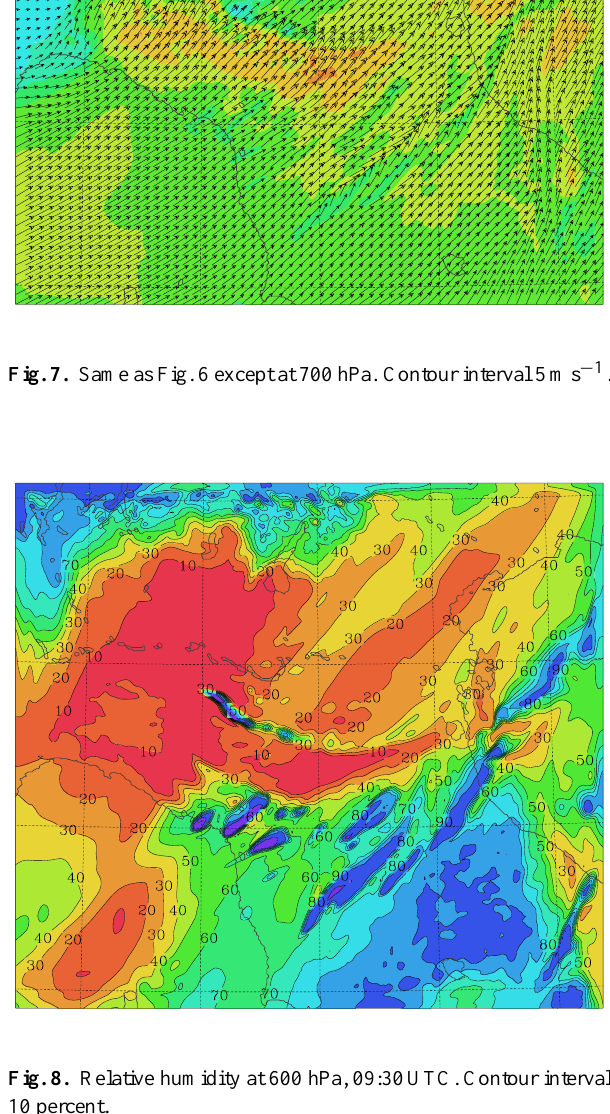
Fig. 8. Relative humidity at 600 hPa, 09:30UTC. Contour interval 10